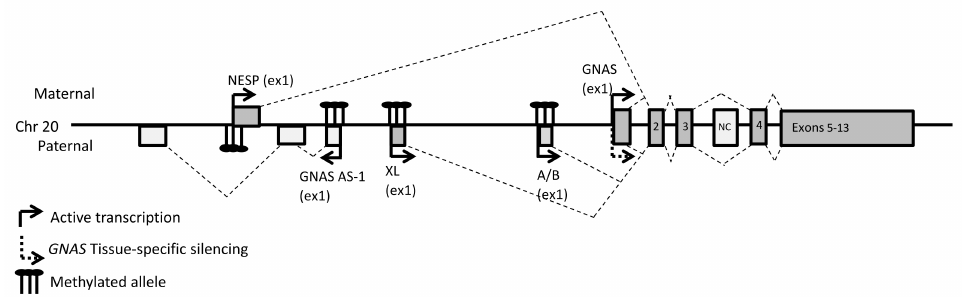
Figure 1. General organization of the GNAS locus. The dark gray and light gray boxes represent the coding and noncoding exons, respectively. The broken lines indicate the splicing patterns. Numbers indicate the numbers of the